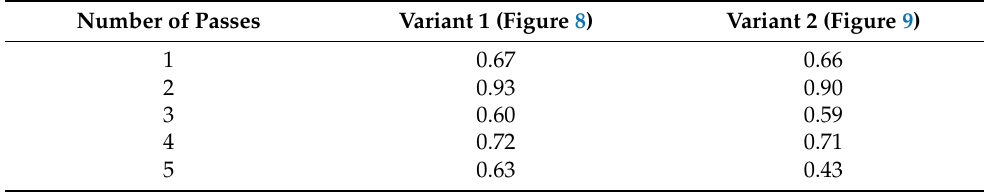
Table 1. Values of standard deviation.